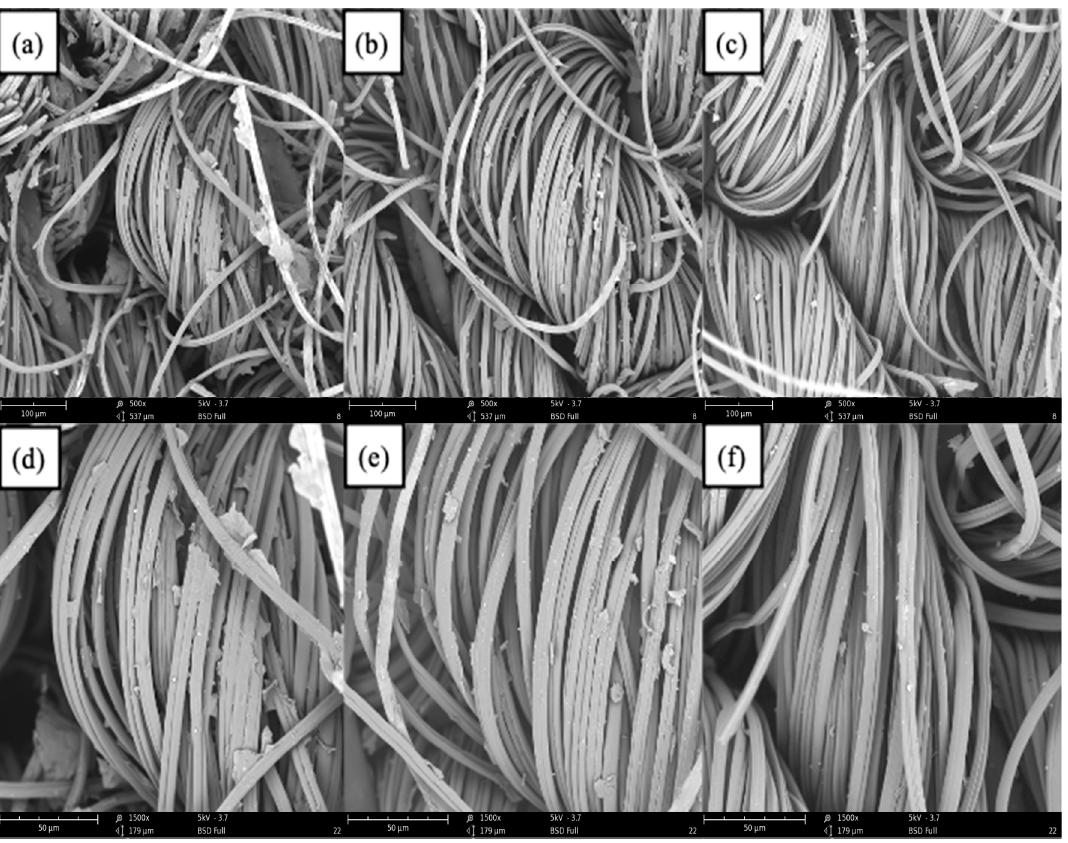
Figure 11. SEM images of graphene conductive fabric immersed in NaCl solution with a different time ( a – c ) are immersed for 1, 2, and 3 h, respectively, and imaged at 1500× magnification; images ( d – f ) are the part enlarge of images ( a – c ), respectively.).